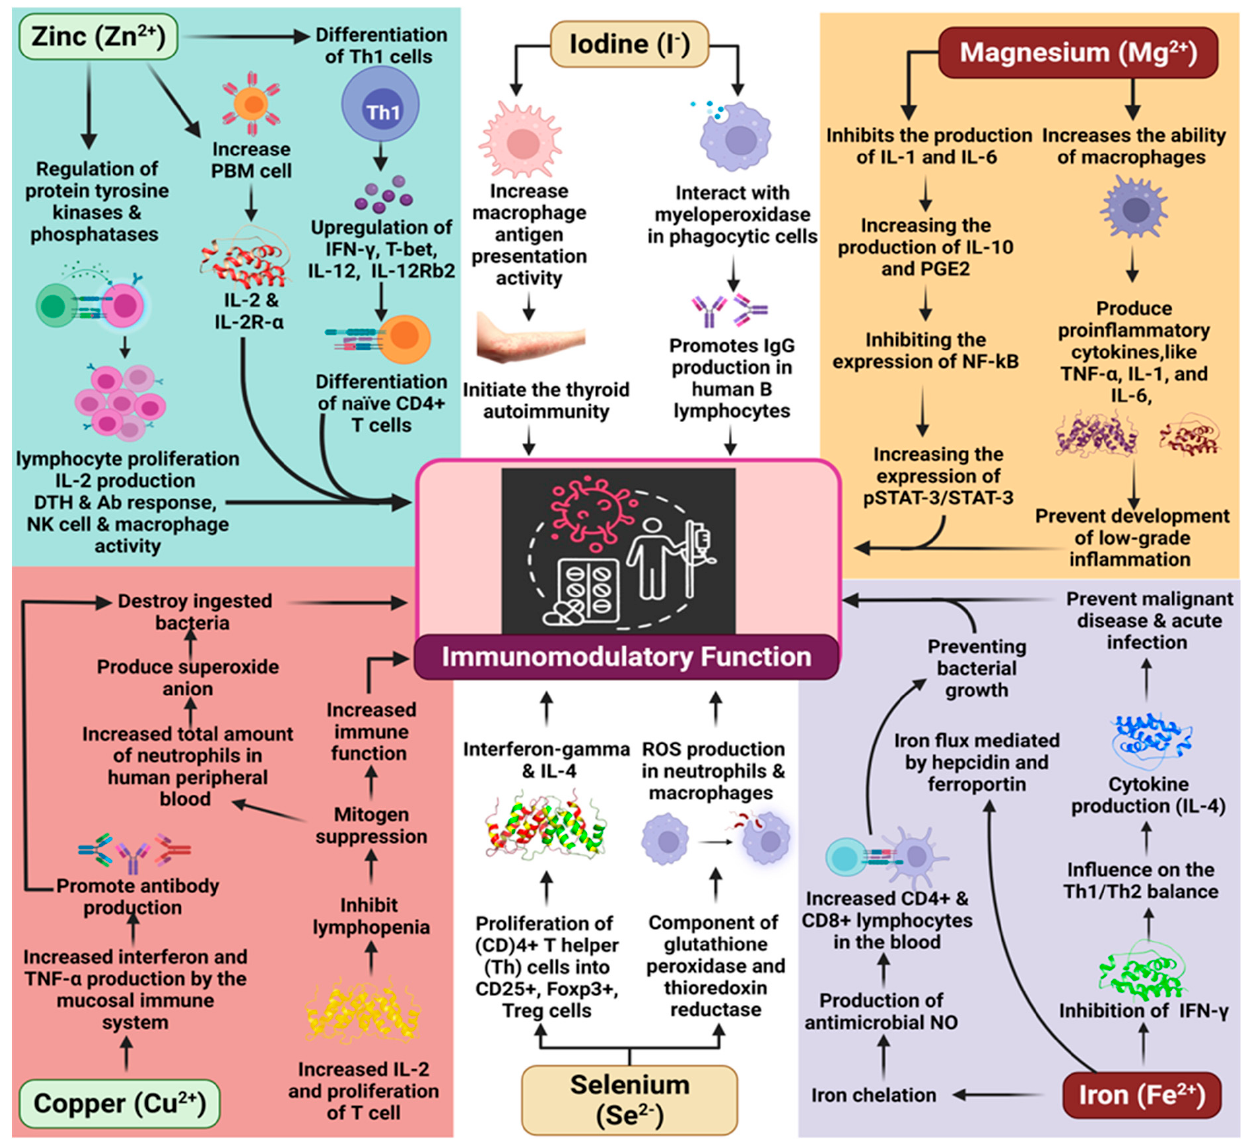
Figure 2. The key role of minerals as immunomodulators.